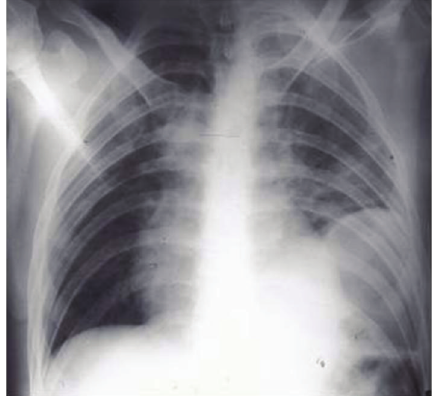
Figure 12: A CXR on a patient with thoracic trauma following a road tra ffi c accident. Diagnosis of a hemopneumothorax was made, but before proceeding to a chest drain placement, a CT scan was obtained as a part of a work up for multiple traumas, which showed a diaphragmatic rupture and herniation of stomach into the left hemithorax explaining the air/fluid at the left lung base.